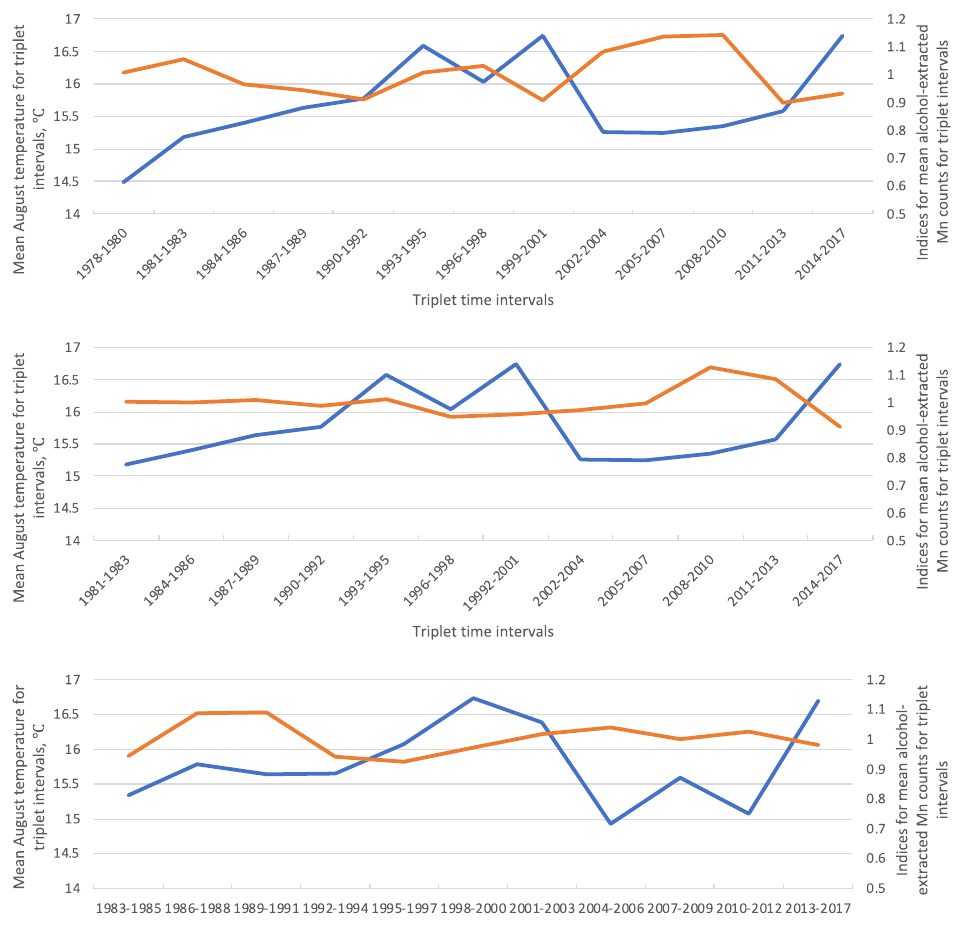
Figure 1. Example time series for August mean temperature and indices for alcohol-extracted Mn counts. Legend: blue lines are the course of the August mean temperatures (means for triplet year intervals), brown lines are the course of alcohol-extracted Mn indices for the triplet year intervals for correspondent Siberian pine trees.